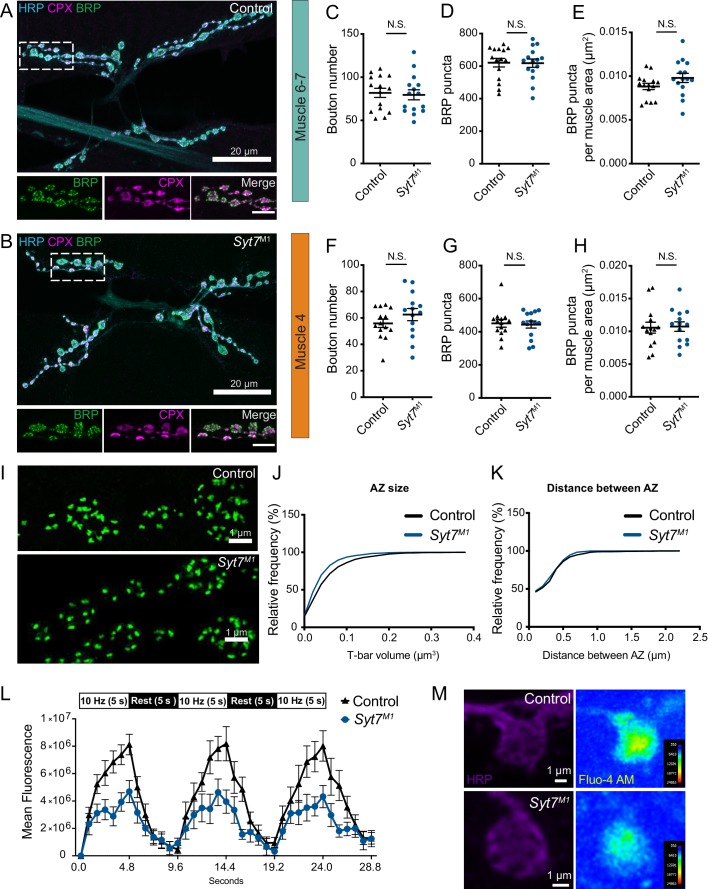
Analysis of synaptic morphology in Syt7 mutants.(A, B) Immunocytochemistry of 3rd instar muscle 6/7 NMJs with anti-HRP (blue), anti-CPX (magenta) and anti-BRP (green) in control and Syt7M1. The boxed region is magnified below with channels showing BRP, CPX and the merge. Scale bar = 20 µm for large panels and 2 µm for boxed regions. Synaptic morphology was quantified for 3rd instar muscle 6/7 (C–E) and muscle 4 (F–H) in controls and Syt7M1 mutants. No significant differences were detected in synaptic bouton number (C, F); muscle 6/7: p=0.78; control: 81.87 ± 5.301, n = 15; Syt7M1: 79.60 ± 5.824, n = 15; muscle 4: p=0.24; control: 55.86 ± 3.141, n = 14; Syt7M1: 62.50 ± 4.575, n = 14), BRP puncta (D, G), muscle 6/7: p=0.94; control: 621.1 ± 26.28, n = 15; Syt7M1: 618.1 ± 25.73, n = 15; muscle 4: p=0.83; control: 450.5 ± 23.25, n = 14; Syt7M1: 443.5 ± 21.47, n = 14) or BRP puncta per muscle surface area (E, H), muscle 6/7: p=0.13; control: 0.0088 ± 0.0004, n = 15; Syt7M1: 0.0098 ± 0.0005, n = 15; muscle 4: p=0.88; control: 0.0105 ± 0.0008, n = 14; Syt7M1: 0.0107 ± 0.0007, n = 14). (I) Anti-BRP staining at 3rd instar muscle four in control and Syt7M1 imaged with SIM microscopy. Scale bar = 1 µm. (J) Relative cumulative frequency of AZ T-bar volume defined with anti-BRP staining at 3rd instar muscle 6/7 NMJs (p=0.026; control: 0.055 ± 0.004 µm2, n = 19 NMJs from five larvae; Syt7M1: 0.044 ± 0.003 µm2, n = 15 NMJs from four larvae). (K) Relative cumulative frequency of T-bar spacing defined by distance between nearest BRP puncta at 3rd instar muscle 6/7 NMJs (p=0.48; control: 0.28 ± 0.016 µm, n = 20 NMJs from five larvae; Syt7M1: 0.27 ± 0.014 µm, n = 15 NMJs from four larvae). Statistical significance was determined with Student’s t-test. (L) Mean fluorescence intensity of Fluo-4 AM in control (black) and Syt7M1 mutants (blue) during the indicated stimulation protocol. (M) Representative images of synaptic boutons stained with anti-HRP (left), with Fluo-4 AM maximum fluorescence intensity during stimulation shown on the right for control (above) and Syt7M1 (below). Scale bar = 1 µm.